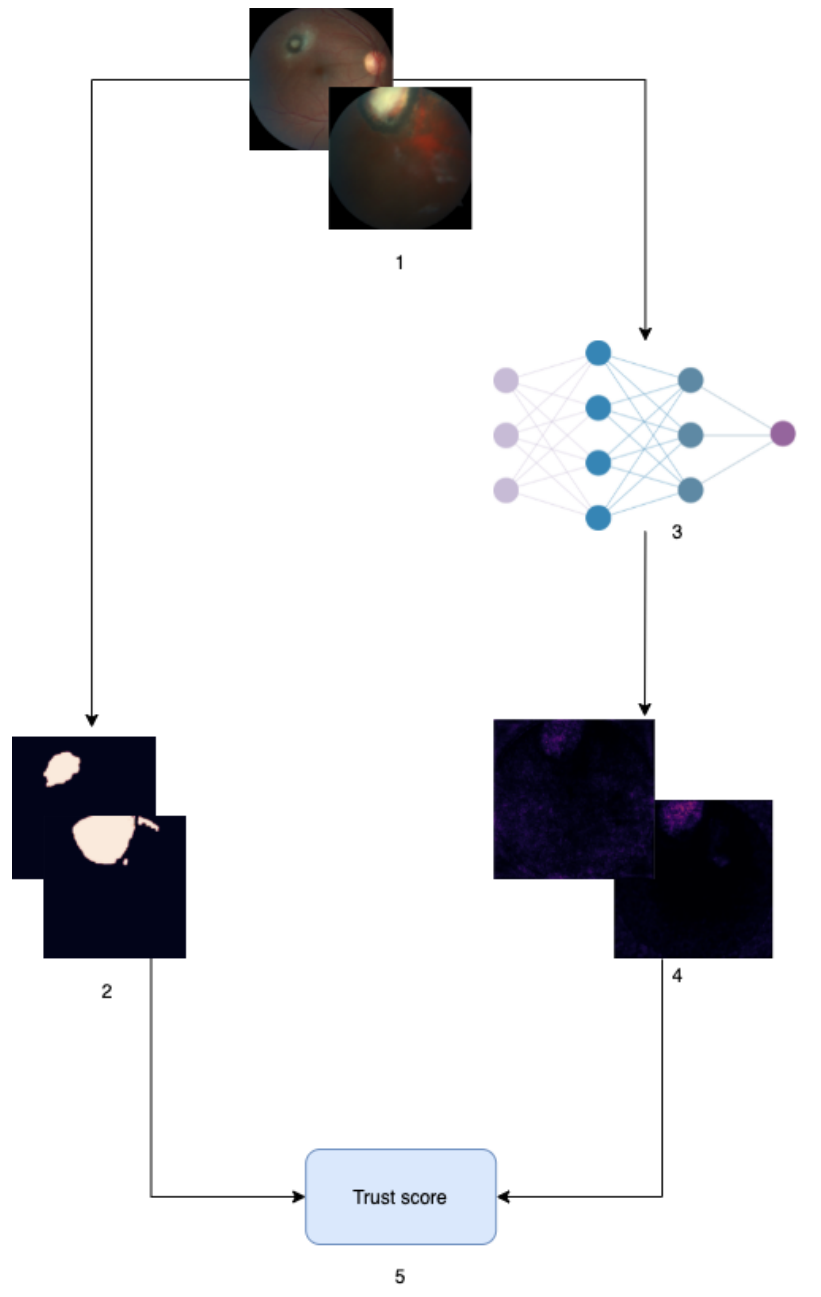
Figure 5. A schematic overview of the general process for trust